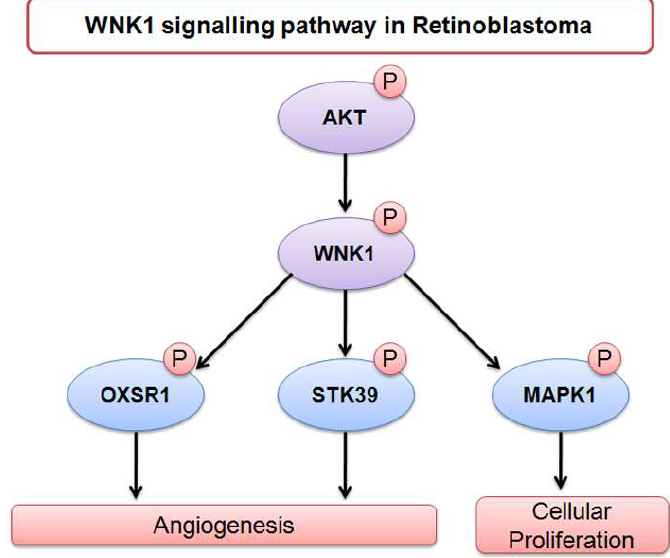
Figure 5. Upstream kinase and downstream targets of WNK1.